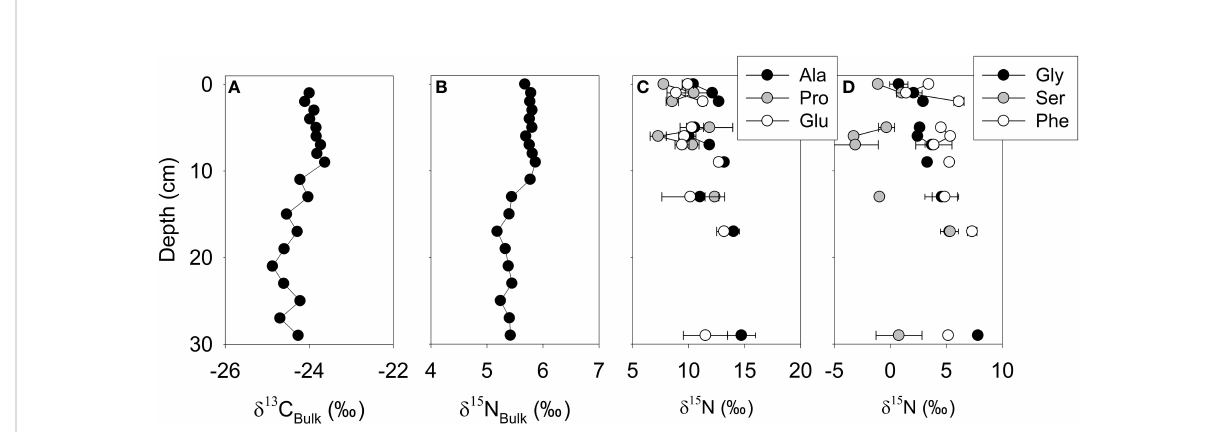
The d 13 C Bulk values ranged from -22.6 to -19.4 ‰ among surface sediments (Figure 5A; Table S2). The highest d 15 N Bulk value was found in the Arctic Ocean (8.9 ‰ ), and the lowest d 15 N Bulk value was observed in the East China Sea (3.9 (Figure 5B and Table S2). The d 15 N AA values of surface sediments exhibited a wider range than those of d 15 N Bulk (3.9 to 8.9 ‰ ) (Figure 6A). Ala showed the widest d 15 N values, ranging spatially from 8.6 to 23.3 ‰ . The d 15 N values of Pro and Glu ranged from 6.3 to 17.2 ‰ and from 7.5 to 17.4 ‰ , respectively (Figure 5C and Table S6). Gly, Ser, and Phe demonstrated a wider d 15 N range compared to bulk sediment (Figure 5D and Table S6). Gly (1.7 to 11.5 ‰ ) displayed the widest d 15 N range within those three AAs. The d 15 N values of Ser and Phe ranged from − 2.9 to 10.9 ‰ and 2.3 to 13.8 ‰ ,